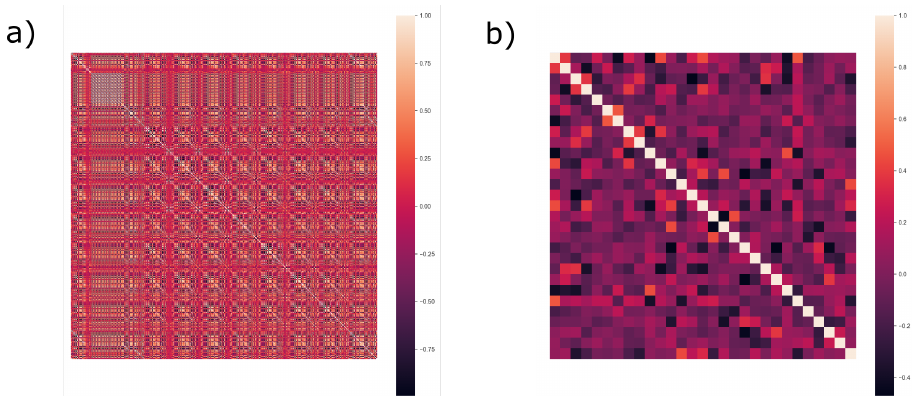
Figure 3. Correlation matrices on the features extracted from D1. ( a ) Correlation matrix before features reduction ( k = 495). ( b ) Correlation matrix after feature reduction ( k = 29).